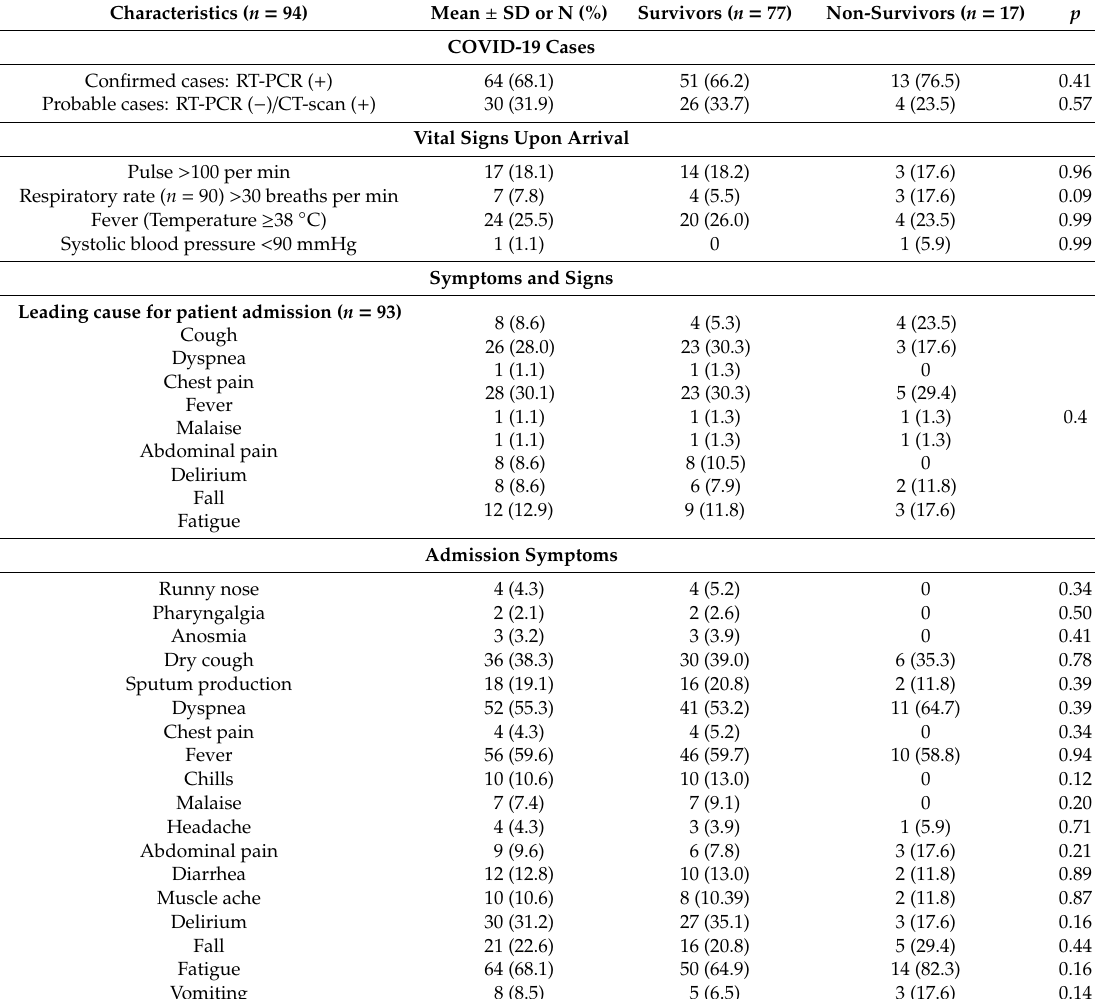
Table 2. Admission characteristics of older patients with